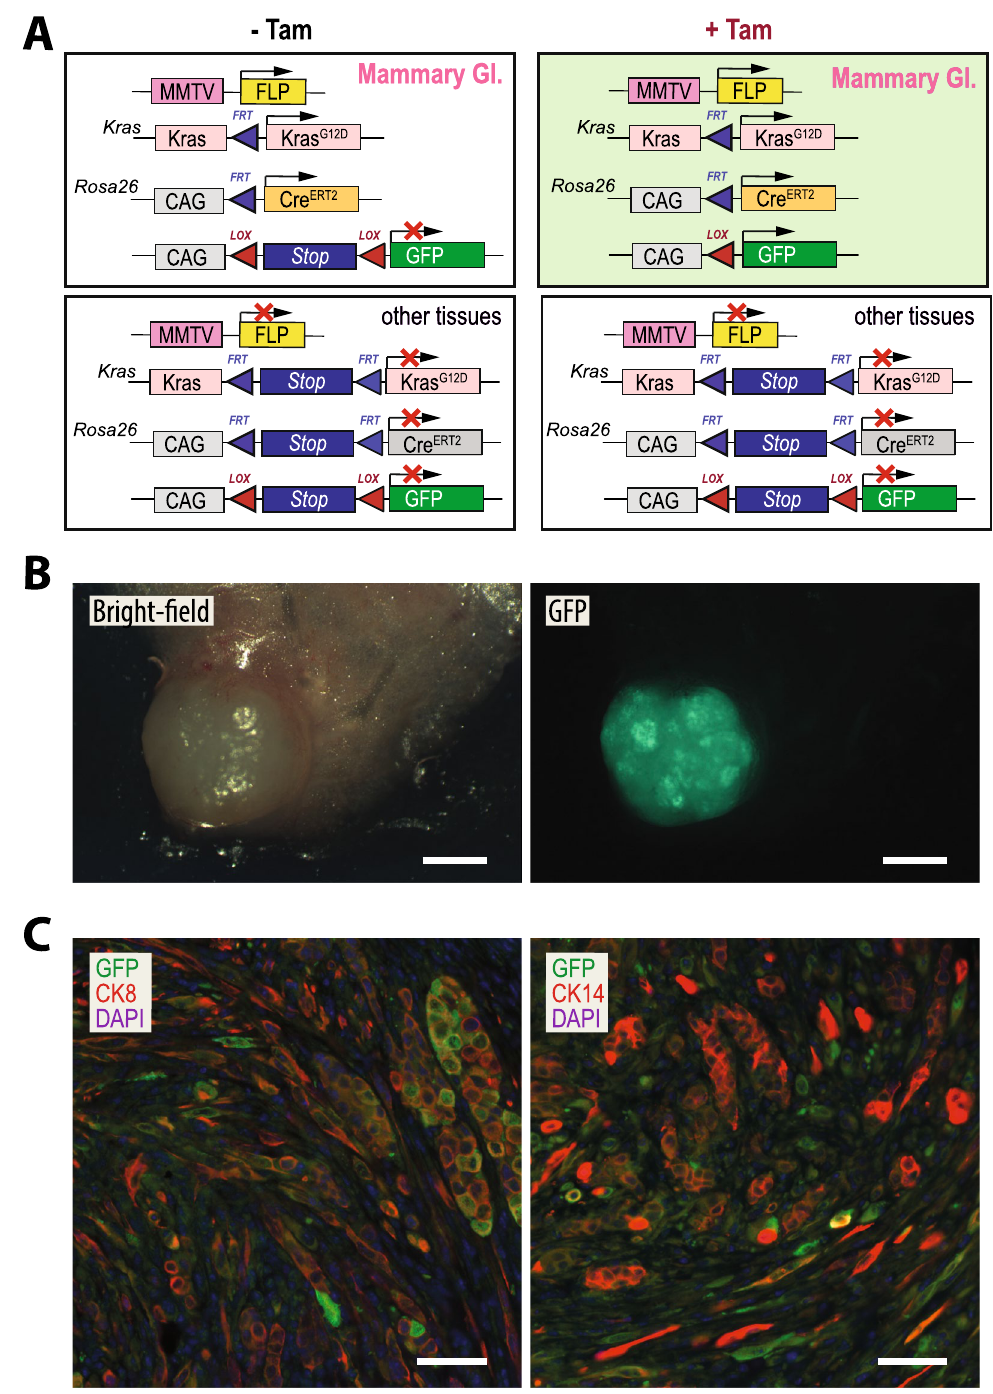
Figure 6. Testing the dual functionality of the Flp and Cre recombinases in KRAS-driven mammary cancers. ( A ) Diagram of the MMTV-Flp/Cre ERT2 -codependent expression of GFP from a Cre/loxP reporter transgene (CAG-LSL-GFP) in KRAS G12D -induced mammary tumors in response to the treatment with tamoxifen (Tam). ( B ) Bight-field and GFP fluorescent images of a mammary tumor from an MMTV-Flp FSF-Kras G12D Rosa26 CAG-FSF-CreERT2 CAG-LSL-GFP quadruple transgenic female that was treated with Tam; bar, 2 mm. ( C ) Immunofluorescent staining of GFP (green) along with cytokeratins (CK) 8 or 14 (both red) in mammary tumor sections of a Tam-treated quadruple transgenic female; bars, 50